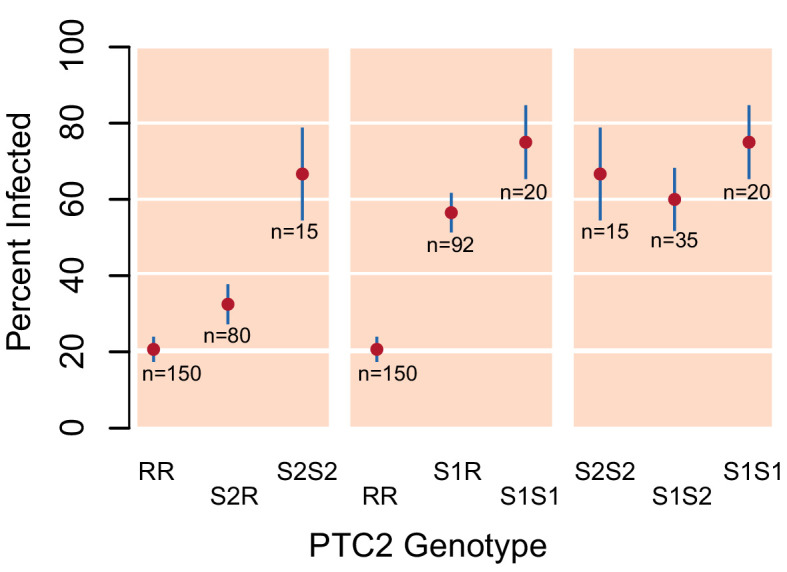
Validation of PTC2 association with infection (Source code 1).Among 392 snails that had previously been parasite-challenged and phenotyped, we see a significant association with PTC2, independently confirming the signal in our main dataset (Figure 1B).